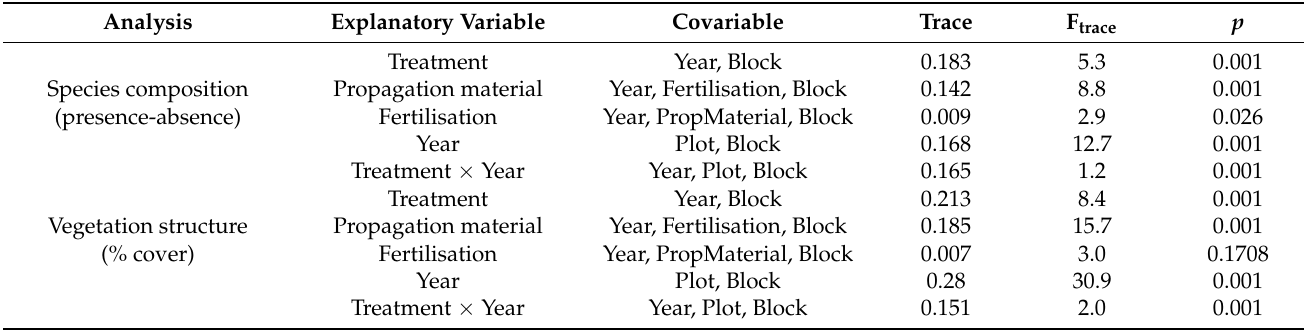
Table 3. Effect of six propagation materials, two fertilisation treatments, and years on the species composition (presence– absence data) and vegetation structure (cover data) in a ski slope grassland restoration experiment calculated in RDA analyses. Plot is a dummy variable used to define individual experimental